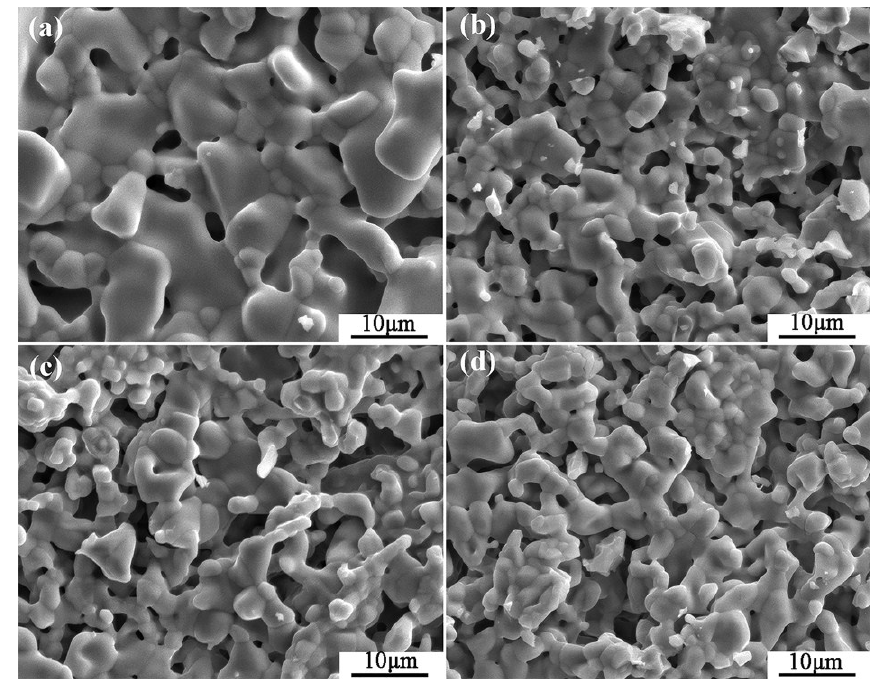
Figure 1. The SEM micrographs of the composite crucibles with specific components. ( a ) The pure Y 2 O 3 crucible; ( b ) Al 2 O 3 -A crucible, containing 3.5 wt % Al 2 O 3 ; ( c ) Al 2 O 3 -B crucible, containing 7.0 wt % Al 2 O 3 ; ( d ) Al 2 O 3 -C crucible, containing 10.5 wt % Al 2 O 3 .